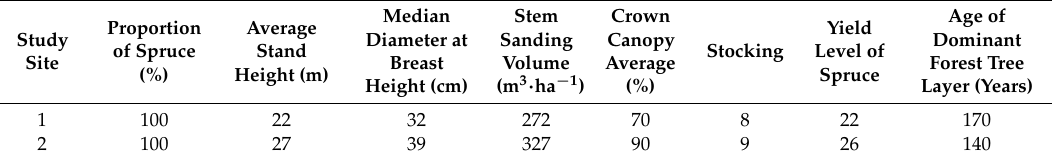
Table 1. Dendrometric characteristics of forest stands in study sites 1 and 2 (study area National Nature Reserve Serak ‐ Keprnik (NNR S ‐ K)).